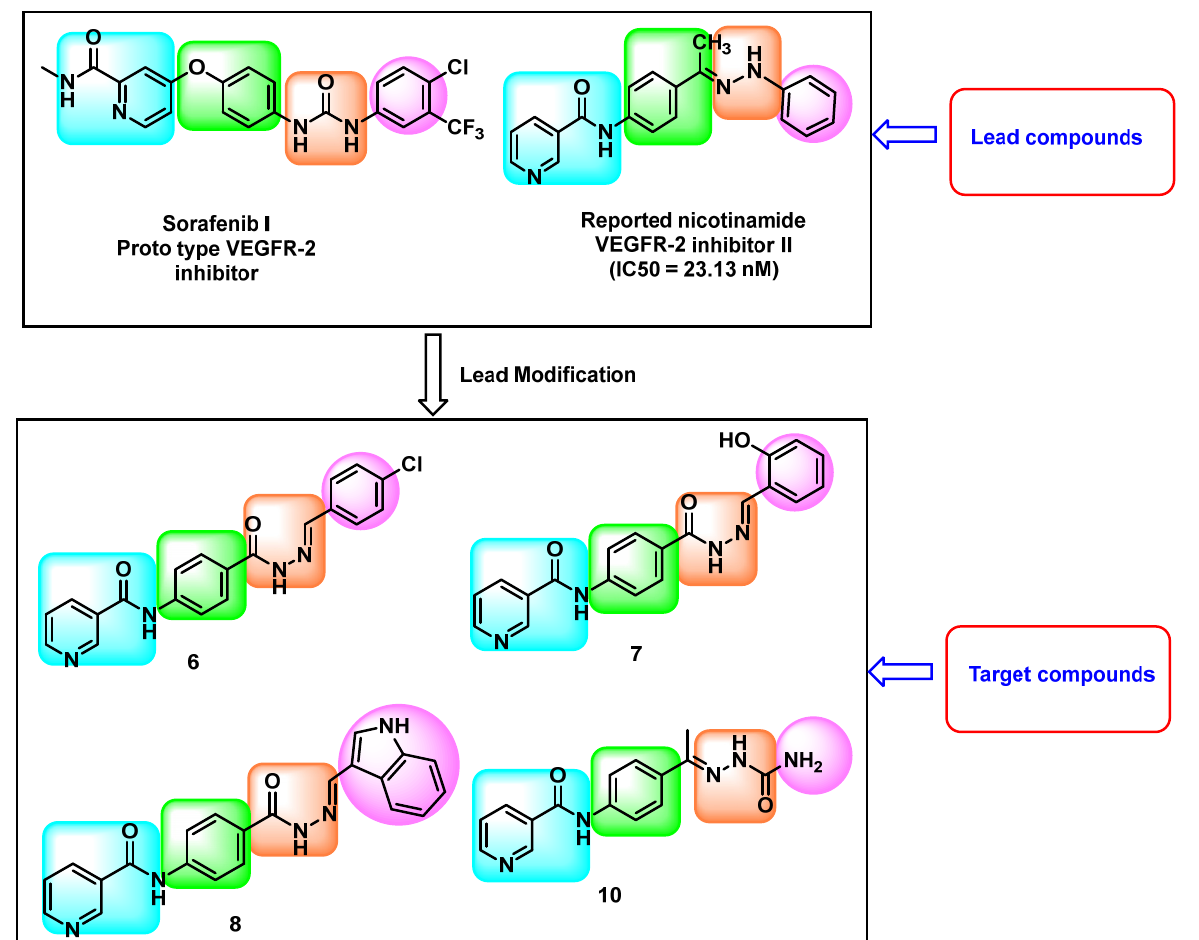
Figure 2. The design rationale of the targeted compounds including the incorporation of hydrophilic groups at the hydrophobic tails of the synthesized compounds. groups at the hydrophobic tails of the synthesized